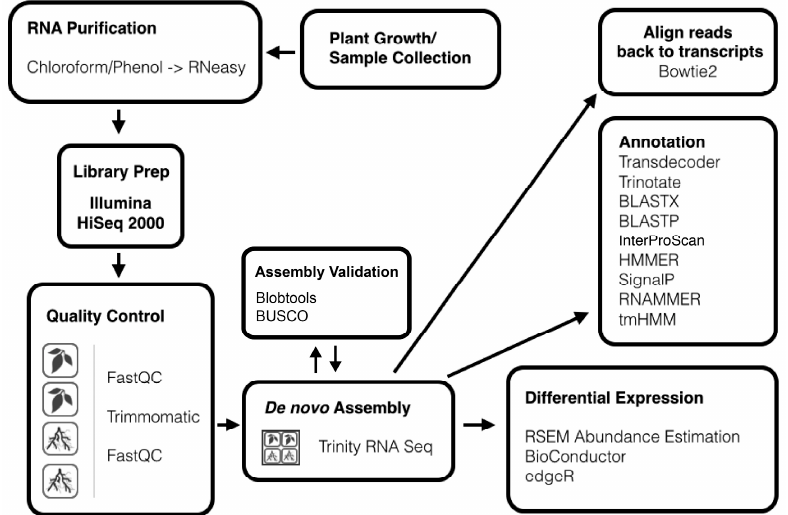
Figure 1. Process for de novo RNA-seq assembly and annotation. RNA from two replicates each of roots and leaves was sequenced with an Illumina HiSeq 2000. Trinity RNA seq was used to de novo assemble a reference transcriptome from the combined paired reads from all four T. radicans leaves and roots samples. Assembled transcripts were then annotated using a variety of programs.